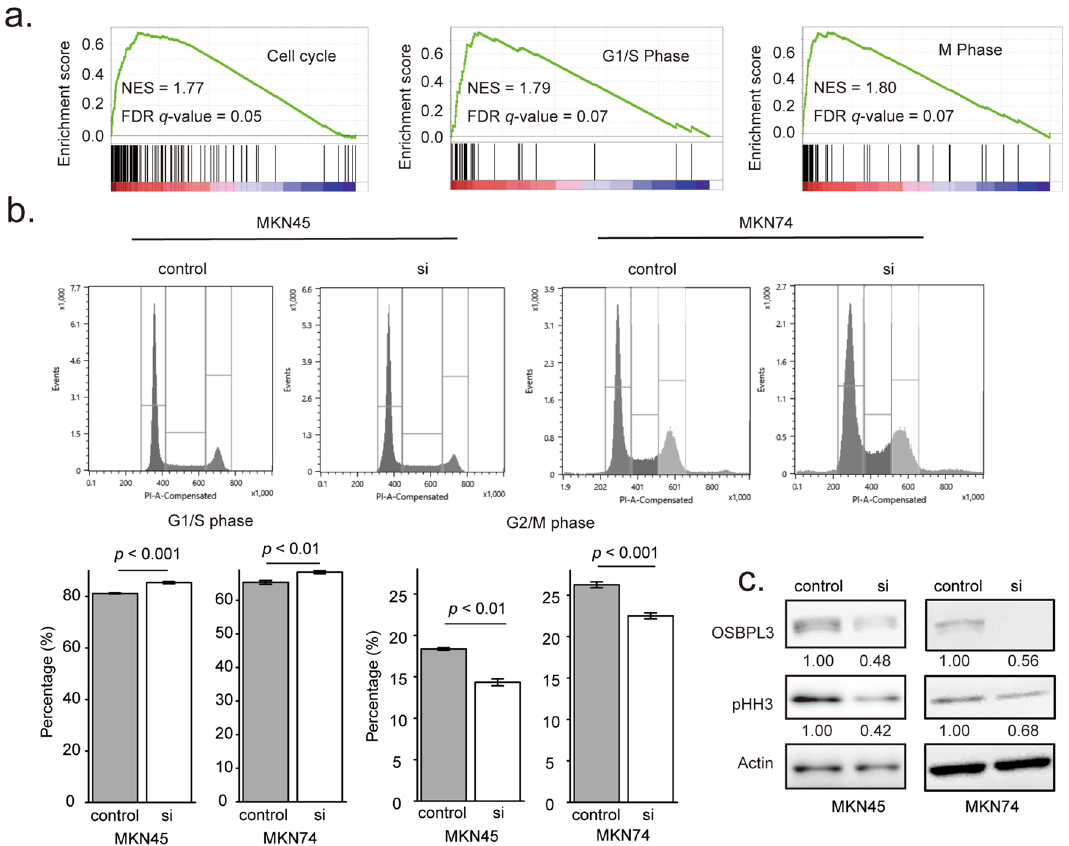
Figure 3. Effect of OSBPL3 on cell cycle progression in GC cells. ( a ) GSEA based on OSBPL3 mRNA expression in 415 tumor tissues from GC patients in TCGA. ( b ) Representative images of flow cytometry analysis of cell cycle progression in GC cells (upper panels). The bottom panels show the percentages of cells in the G1/S and G2/M phases, respectively, among GC cells (MKN45 and MKN74) transfected with siRNAs. si: siRNA targeting OSBPL3 . N = 3, error bars represent the mean ± SD. Student’s t -test. ( c ) The protein levels of OSBPL3, pHH3, and actin in GC cells (MKN45 and MKN74) transfected with siRNAs. si: siRNA targeting OSBPL3